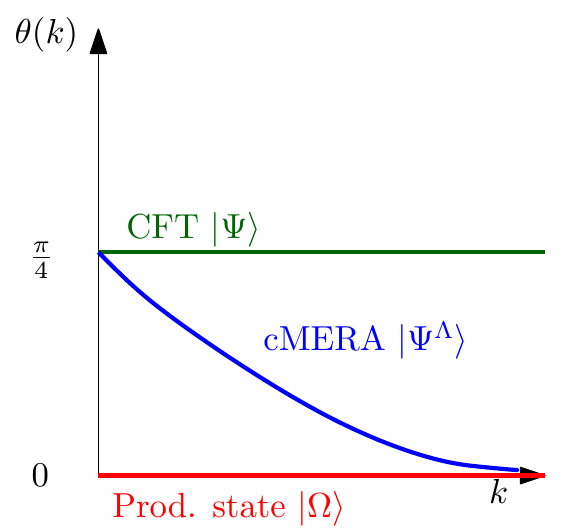
Figure 12 . Qualitative plot of the characteristic function (cid:18) ( k ) for the three states in the fermionic cMERA construction. The behaviour shown for the cMERA is closest to the one obtained by choosing j =